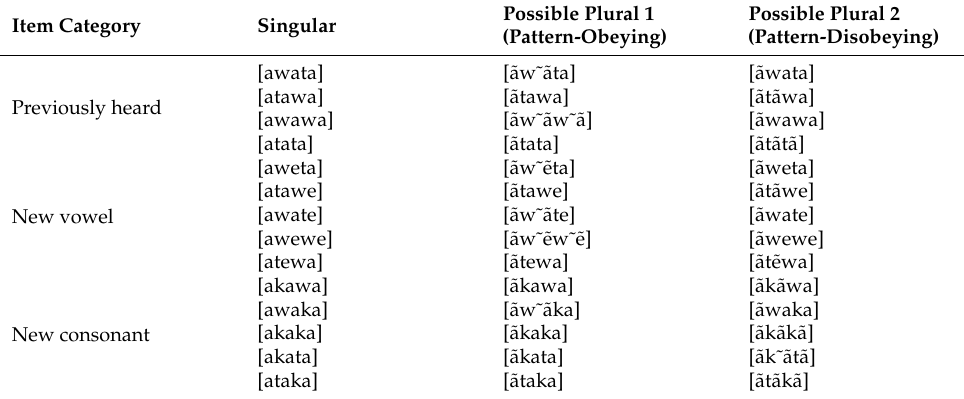
Table 6. Test stimuli presented to the group exposed to the natural